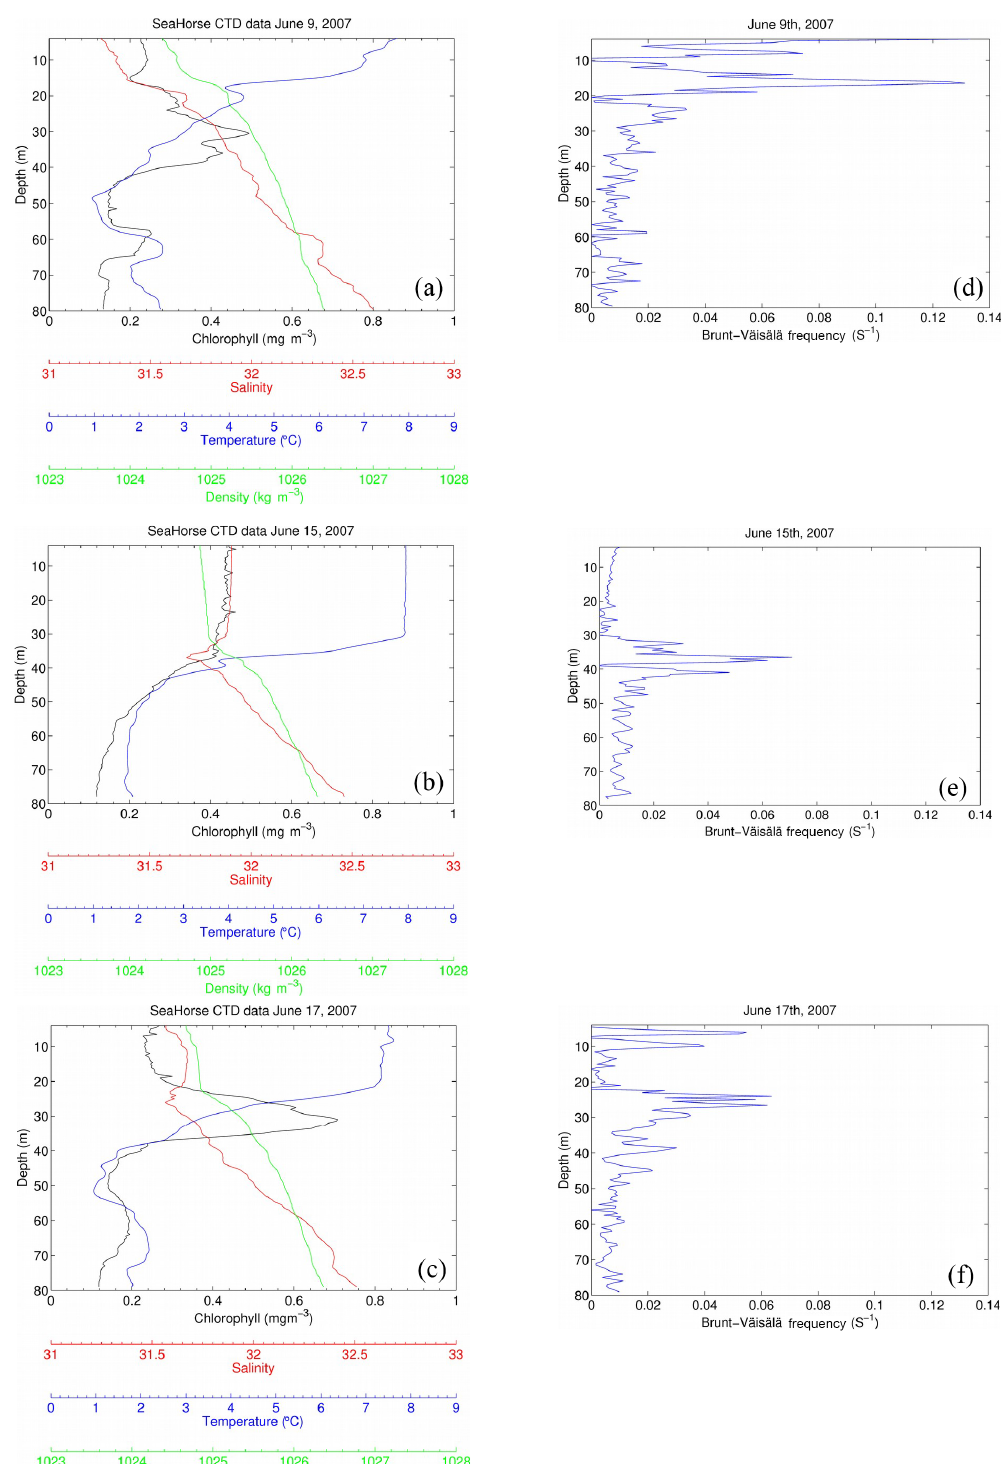
Figure 9. SeaHorse snapshots of a storm event between 9 June and 17 June 2007. The x axis contains chlorophyll (mgm − 3 ), salinity, temperature ( ◦ C), and density (kgm − 3 ), and the y axis is depth in meters. Wind speeds (ms − 1 ) for each day (05:00 to correspond with the time of SeaHorse data) are included in each panel. Fluorescence values are calibrated to in situ bottle data collected at HL2. The right-hand panels show the Brunt–Väisälä frequency for the respective